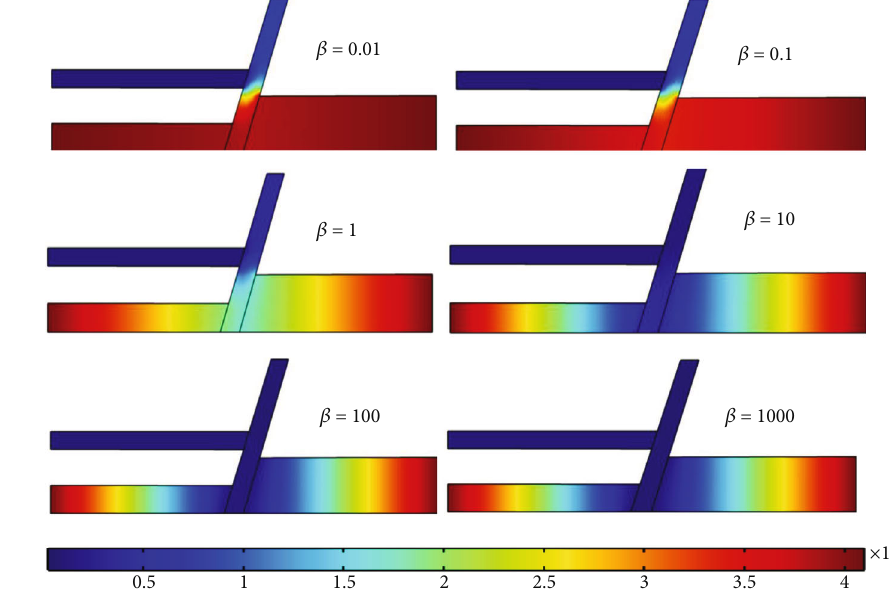
Figure 3: Fluid pressure pro fi le under di ff erent gamma.